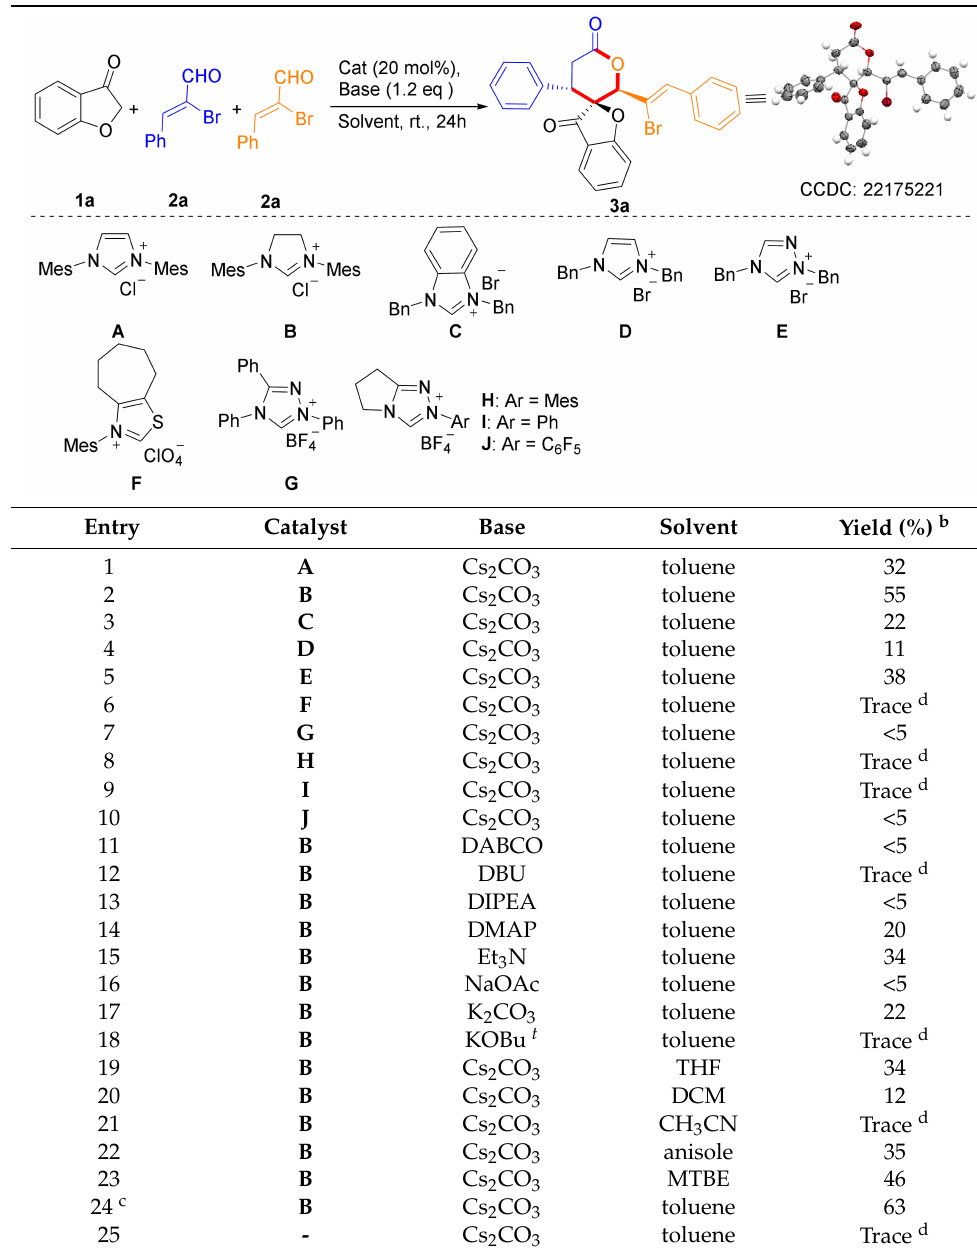
Table 1. Optimization of reaction conditions a